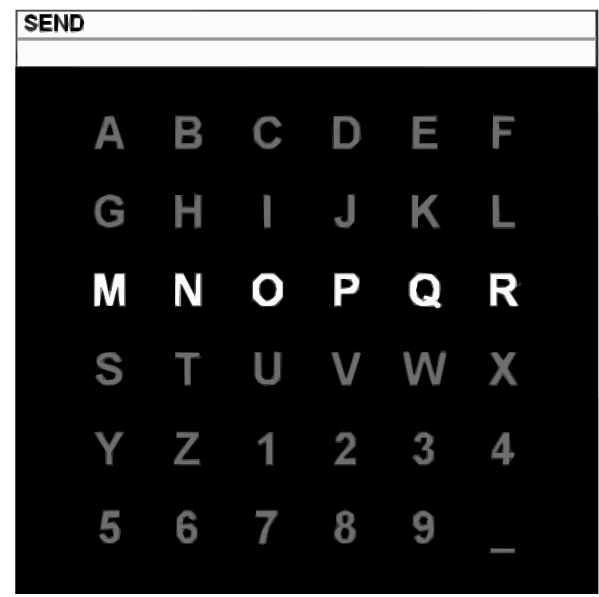
Figure 2. The speller matrix used in this work. Source: BCI Competition II dataset description.